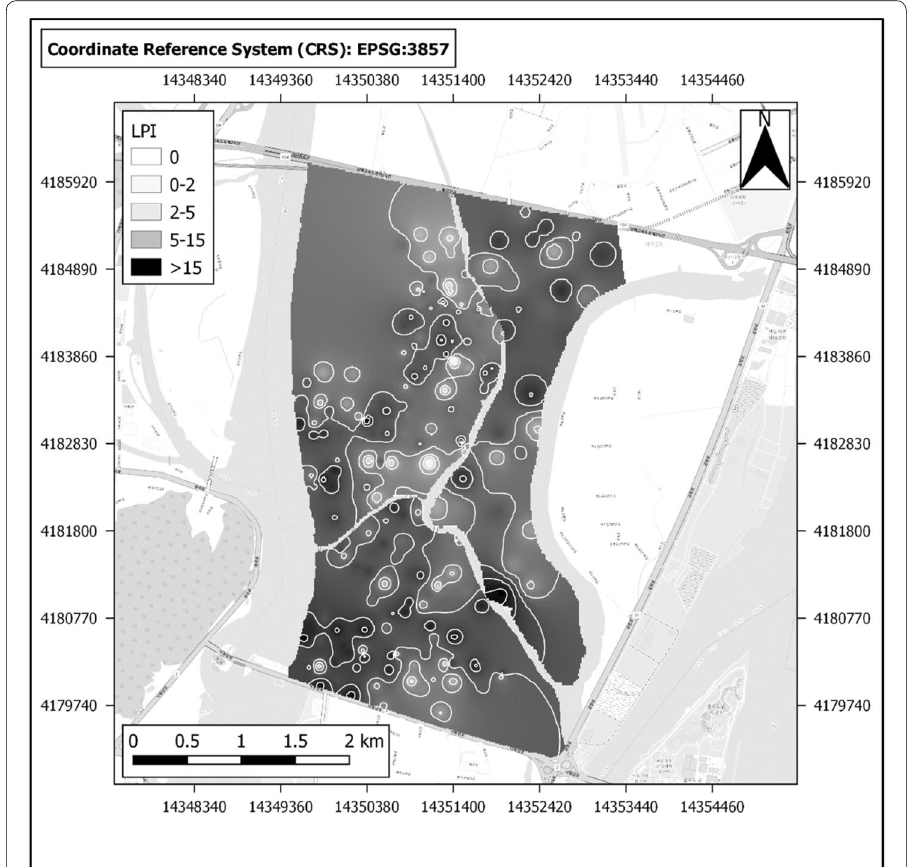
Fig. 14 Liquefaction hazard map based on Seed and Idriss [1] method for case